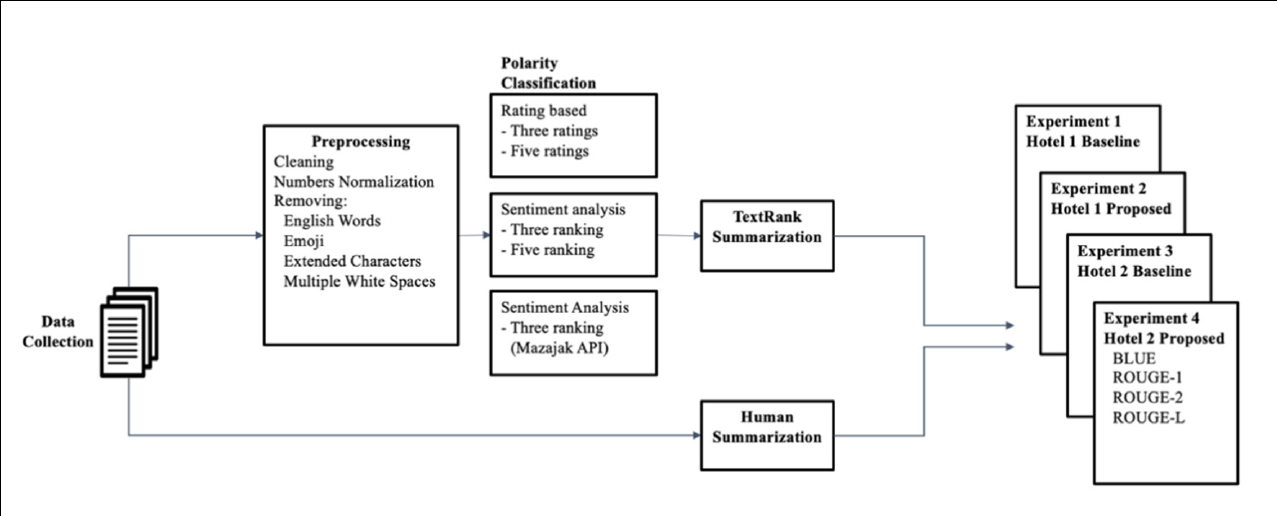
Figure 1. Proposed methodology stages.